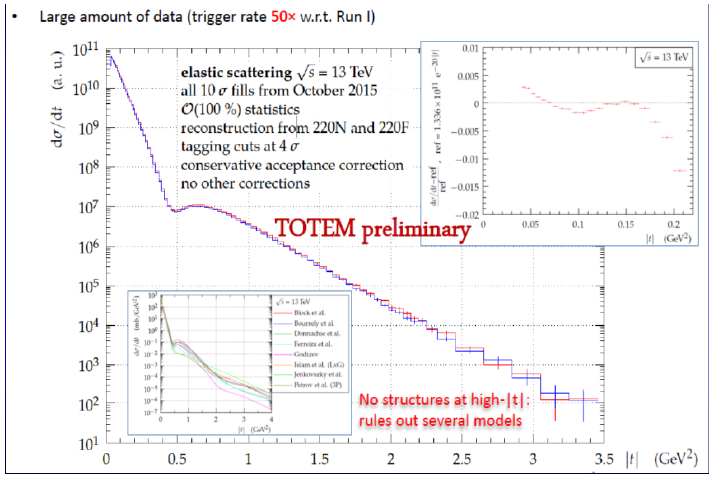
Fig. 5. The differential cross section of elastic scattering of protons at 13 TeV [30]. Figure 5. The differential cross section of elastic scattering of protons at 13 TeV